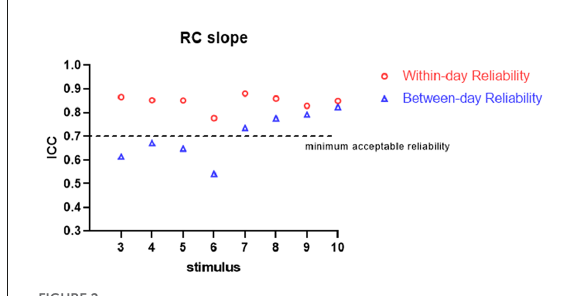
FIGURE2 Within-day and between-day reliability of RC slope. ICC, intraclass correlation coefficient.